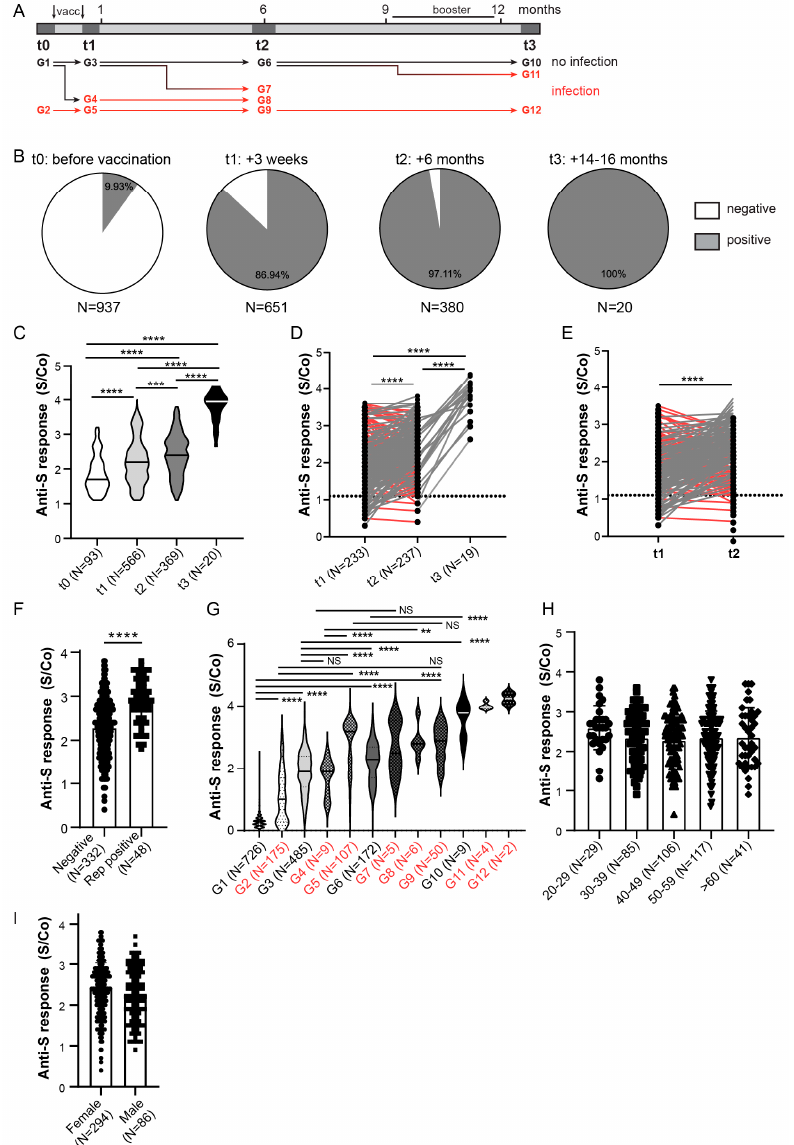
Figure 2. Anti-Spike antibody response in HCW cohort. ( A ) Schematic of serum collection and groups analyzed in ( G ) in relation to timing of SARS-CoV-2 infection. ( B ) Anti-Spike (anti-S) seroconversion rates (above cut-off value) in HCWs at different sera collection time points. ( C ) Comparison of the anti-Spike antibody response between entire cohort of seroconverted individuals (S/Co > 1.1). ( D ) Comparison of the anti-Spike antibody response between all paired samples or ( E ) paired samples that were not Spike seroconverted prior to vaccination or Nucleocapsid protein seroconverted at any time point. Red lines samples displaying reduced anti-S response between t1 and t2 analyses. ( F ) Comparison of anti-Spike antibody S/Co 6-months post vaccination (t2) stratified to participants’ self-reported PCR confirmed COVID-19 infection. ( G ) Comparison of the anti-Spike antibody re- sponse in relation to timing of infection assessed by Nucleocapisd seroconversion and self-reported, PCR confirmed COVID-19 infection. ( H ) Comparison of anti-Spike antibody S/Co 6 months post vaccination (t2) stratified to participants’ age or ( I ) gender. S/Co, Signal to cut-off ratio; dashed line indicates cut-off value (S/Co = 1.1); red lines in D and E show samples with reduction of anti- Spike S/Co; red lines and groups in A and G indicate samples with COVID-19 infection. Statistical tests: ordinary one-way ANOVA followed by Tukey’s multiple comparison test ( C , G ), mixed effect analysis with Holm-Sidak’s multiple comparisons test ( D ), paired two-tailed t -test ( E , H ), p value **** p < 0.0001, p value *** and ** p < 0.05, NS-not